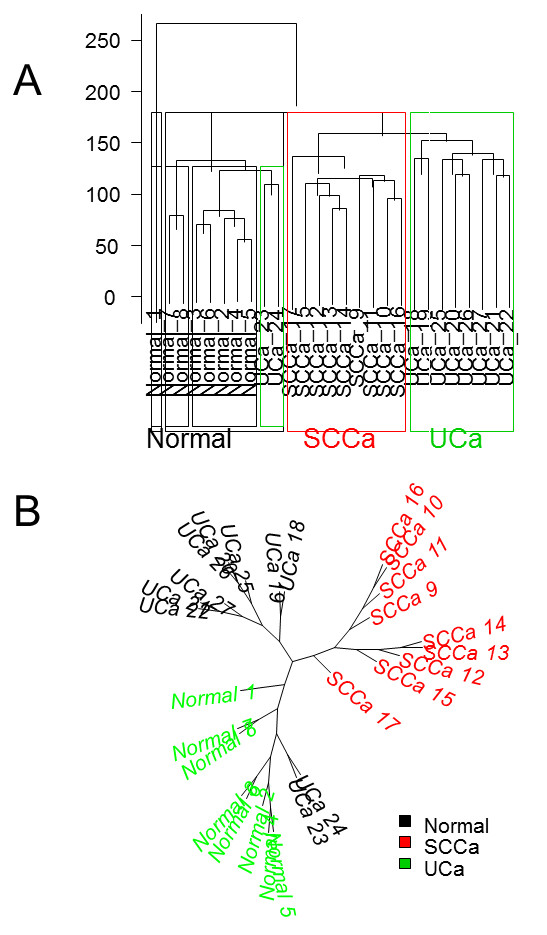
Unsupervised clustering analysis using approximately 4500 genes filtered first by the interquantile range (IQR, >0.3) then by the coefficient of variation (CV, >0.05) resulted in an error rate of 2/27=7.4% (black = UCa; red = SCCa; green = normal) represented as (A) dendrogram and (B) phylogram (unrooted).